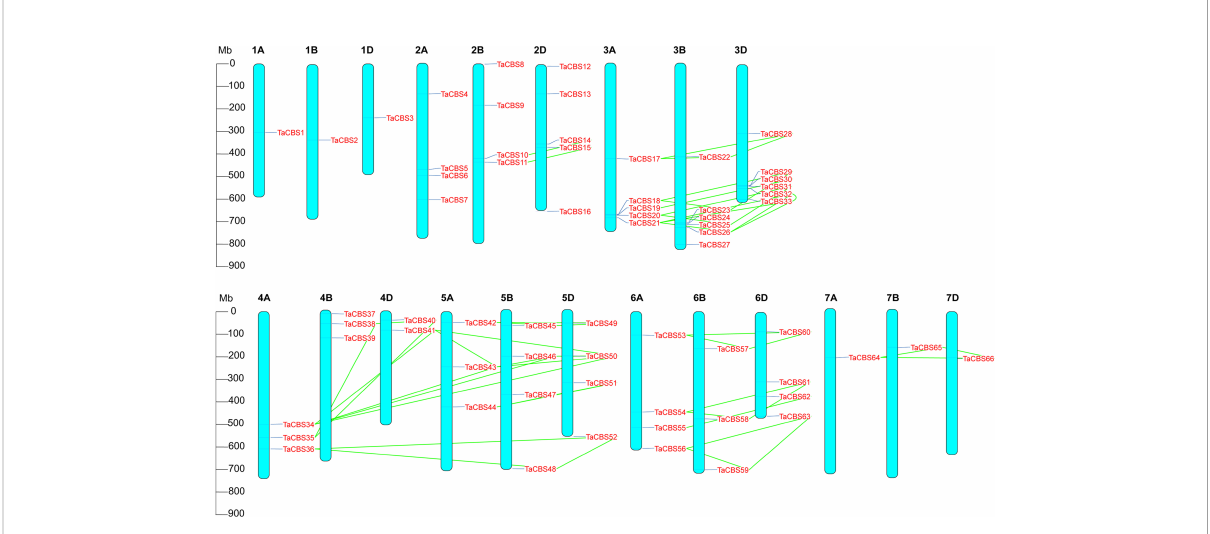
FIGURE 3 Chromosomal localization of the TaCBS genes in the wheat genome. The positions on the linkage map have been determined. 66 TaCBS genes are mapped to 21 chromosomes (1A-7A, 1B-7B, and 1D-7D). Green colored lines represent the connections between duplication events. Megabase pairs (Mb) are used to measure the scale.